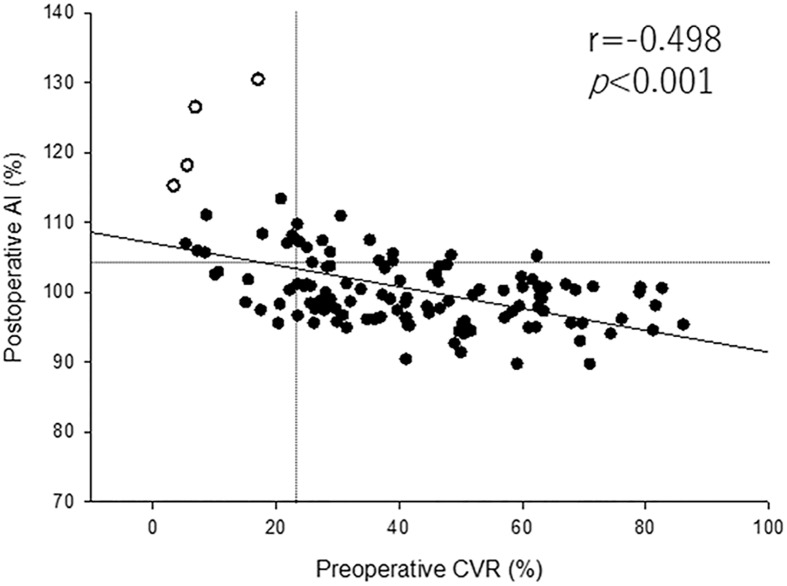
Preoperative cerebrovascular reactivity (CVR) and postoperative asymmetry index (AI) the day after stent placement.A CVR value lower than the mean + 2 SD (i.e., 23.8%) was defined as reduced CVR (vertical line), and an AI value higher than the mean + 3 SD (i.e., 104.6%) was defined as increase in AI (horizontal line). Open circles indicate patients with HPS after CAS.